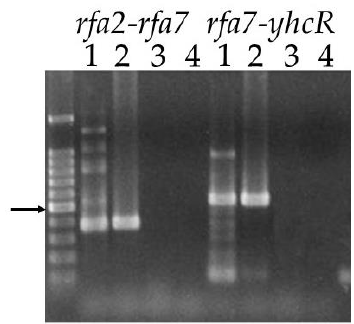
Figure 3. Co-transcription of rfa2 , rfa7 and yhcR . Primers bracketing the intergenic regions rfa2-rfa7 and rfa7-yhcR were used in reactions with different templates. Lane 1: cDNA; Lane 2: genomic DNA; Lane 3: total RNA; Lane 4: no template. Size marker is 1 kb PLUS DNA ladder (Gold Biotechnology, St. Louis, MO, USA). Arrow indicates 500 bp.